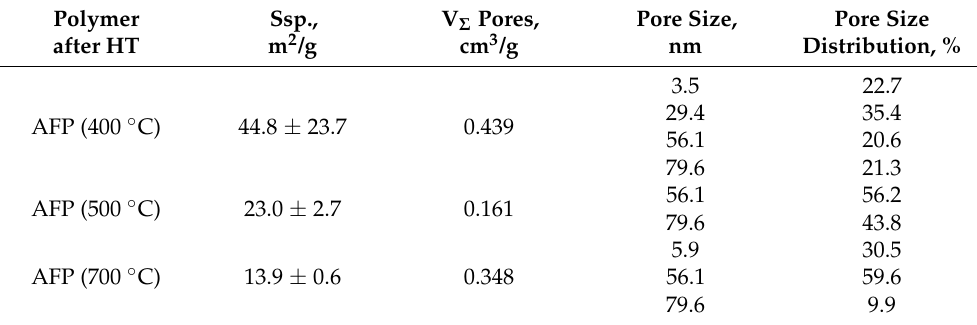
Table 1. Specific surface area and porous structure of AFP samples after heat treatment.